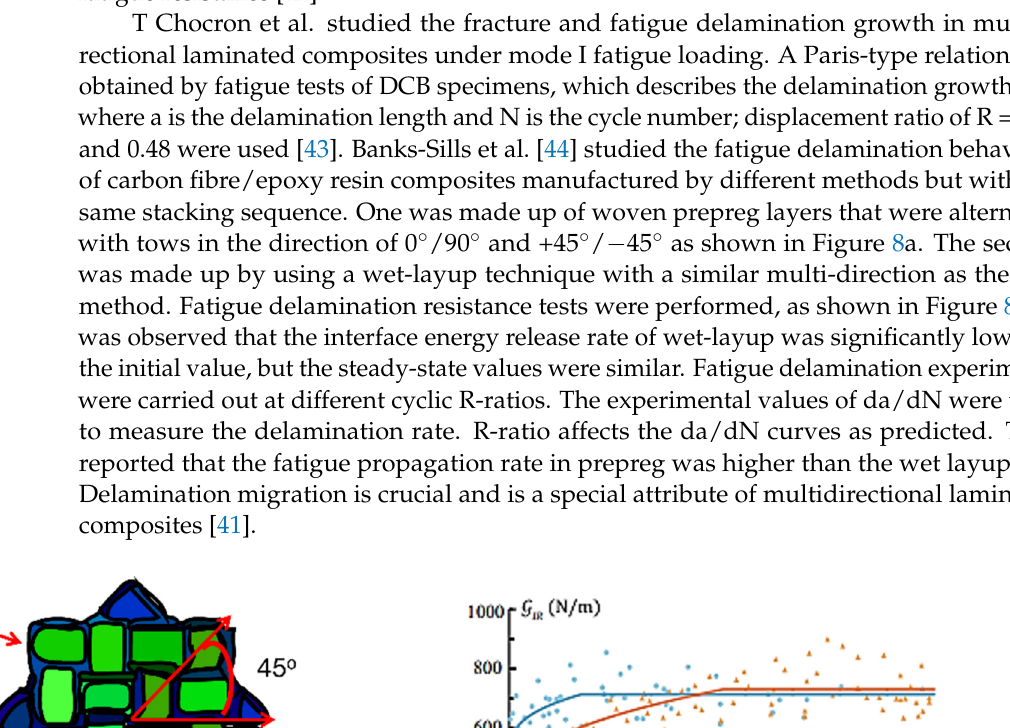
Figure 7. Multidirectional laminated composite structure.